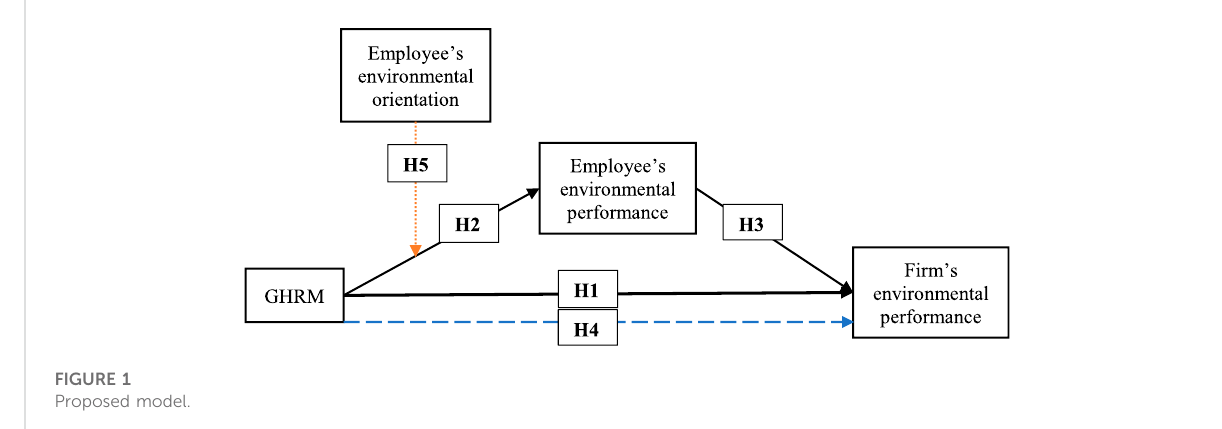
FIGURE 1 Proposed